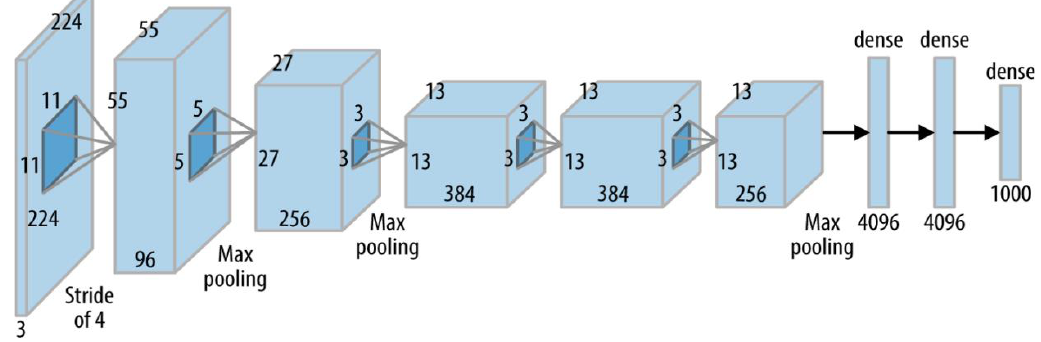
Figure 7. Presents the basic block diagram of SqueezNet model.